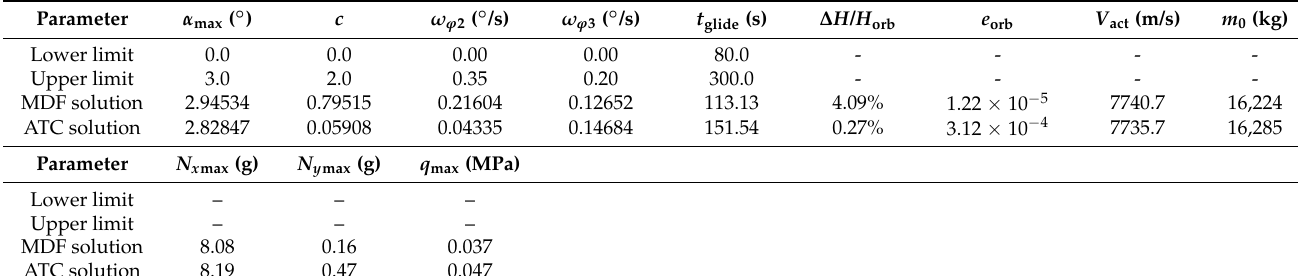
Table 8. Ranges of design variables and optimal results of trajectory